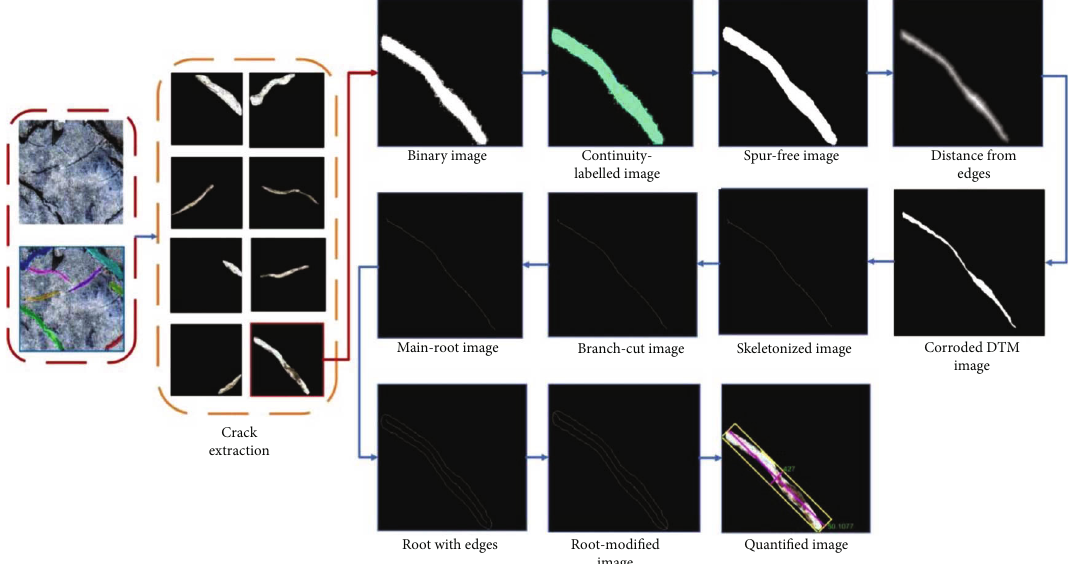
Figure 20: Operating process of the proposed quanti fi cation algorithm.